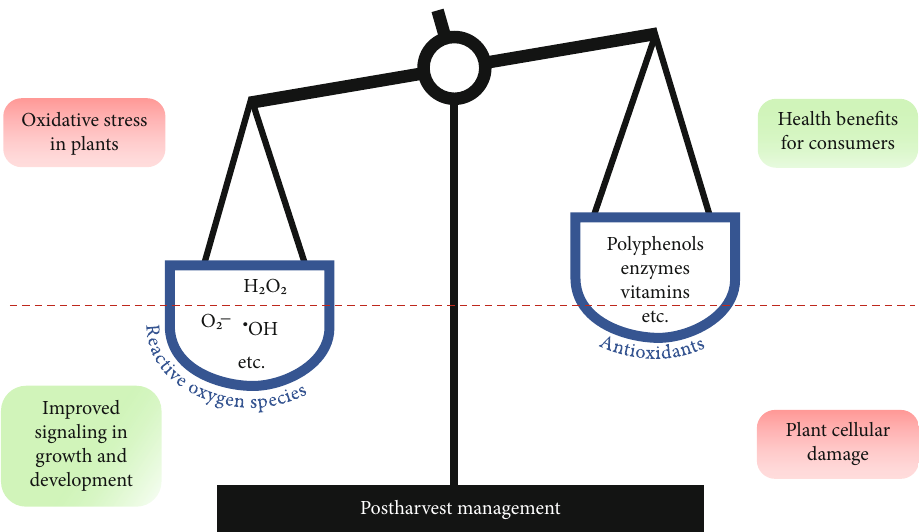
Figure 1: Postharvest management, balancing ROS and antioxidant content to maintain quality and deliver the most bene fi ts to the consumer. The broken red line illustrates the fragile balance between ROS and antioxidant in plants. A moderate level of ROS is often bene fi cial to signal various crucial steps during growth and development, including ripening and increased resistance in a postharvest condition. However, elevated ROS concentration that is not coupled with high antioxidant capacity often poses great risk to the plant tissues. Hence, a suitable method of postharvest would be one that is able to limit ROS production while maintaining high antioxidant